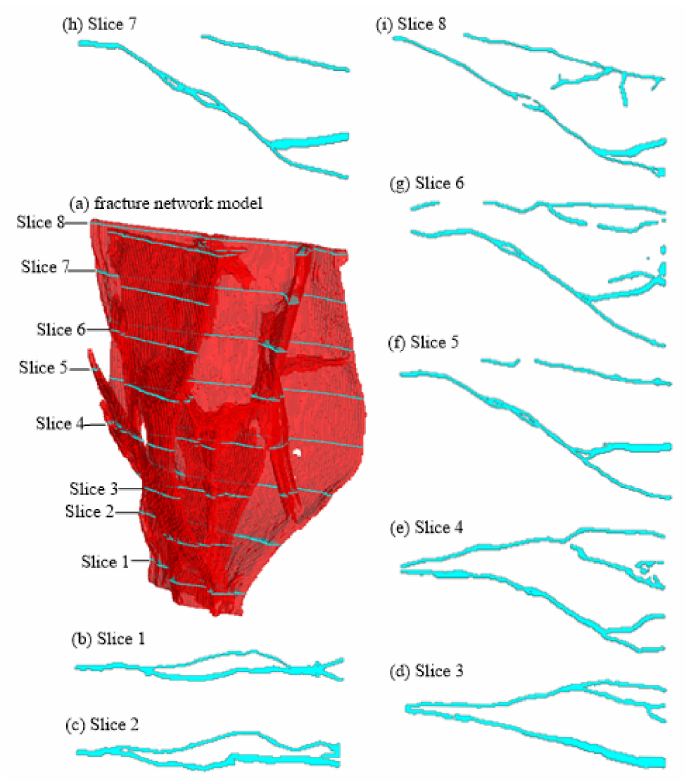
Figure 15. Fracture network specimen geometry and fracture intersections [19].